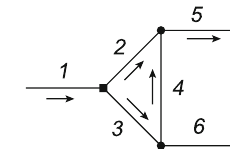
carried on in different ways [29–33]. In general, the